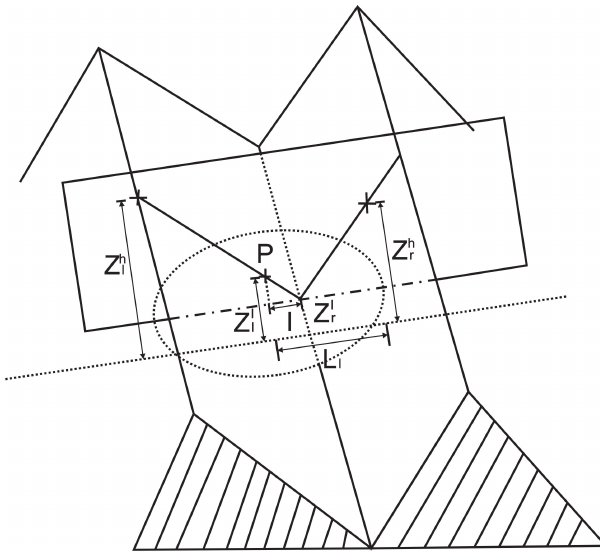
Fig. 7. Scheme of valley identification ( P is the point to be identi- fied. The algorithm searches both the highest and the lowest points on both sides of P , if certain elevation difference can be maintained, then it indicates a possible valley formation).